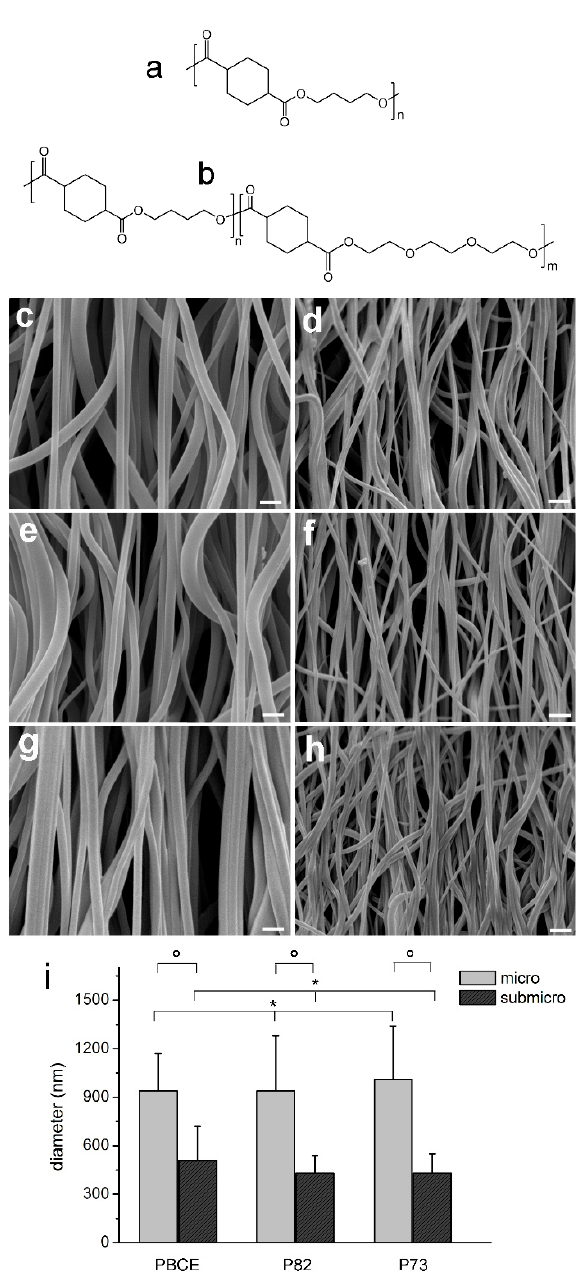
Figure 1. Poly(butylene 1,4-cyclohexanedicarboxylate) homopolymer (PBCE) and poly(butylene 1,4-cyclohexandicarboxylate- co -triethylene cyclohexanedicarboxylate) (P(BCE- co -TECE)) scaffolds. Chemical structures of ( a ) PBCE homopolymer and ( b ) P(BCE- co -TECE) copolymers. SEM micrographs of ( c ) micro-PBCE, ( d ) sub-micro-PBCE, ( e ) micro-P(BCE80- co -TECE20) (P82), ( f ) sub-micro-P82, ( g ) micro-P(BCE70- co -TECE30) (P73), and ( h ) sub-micro-P73. Scale bars = 2 µm. ( i ) Fibre diameters; * p > 0.05; ° p < 0.001.